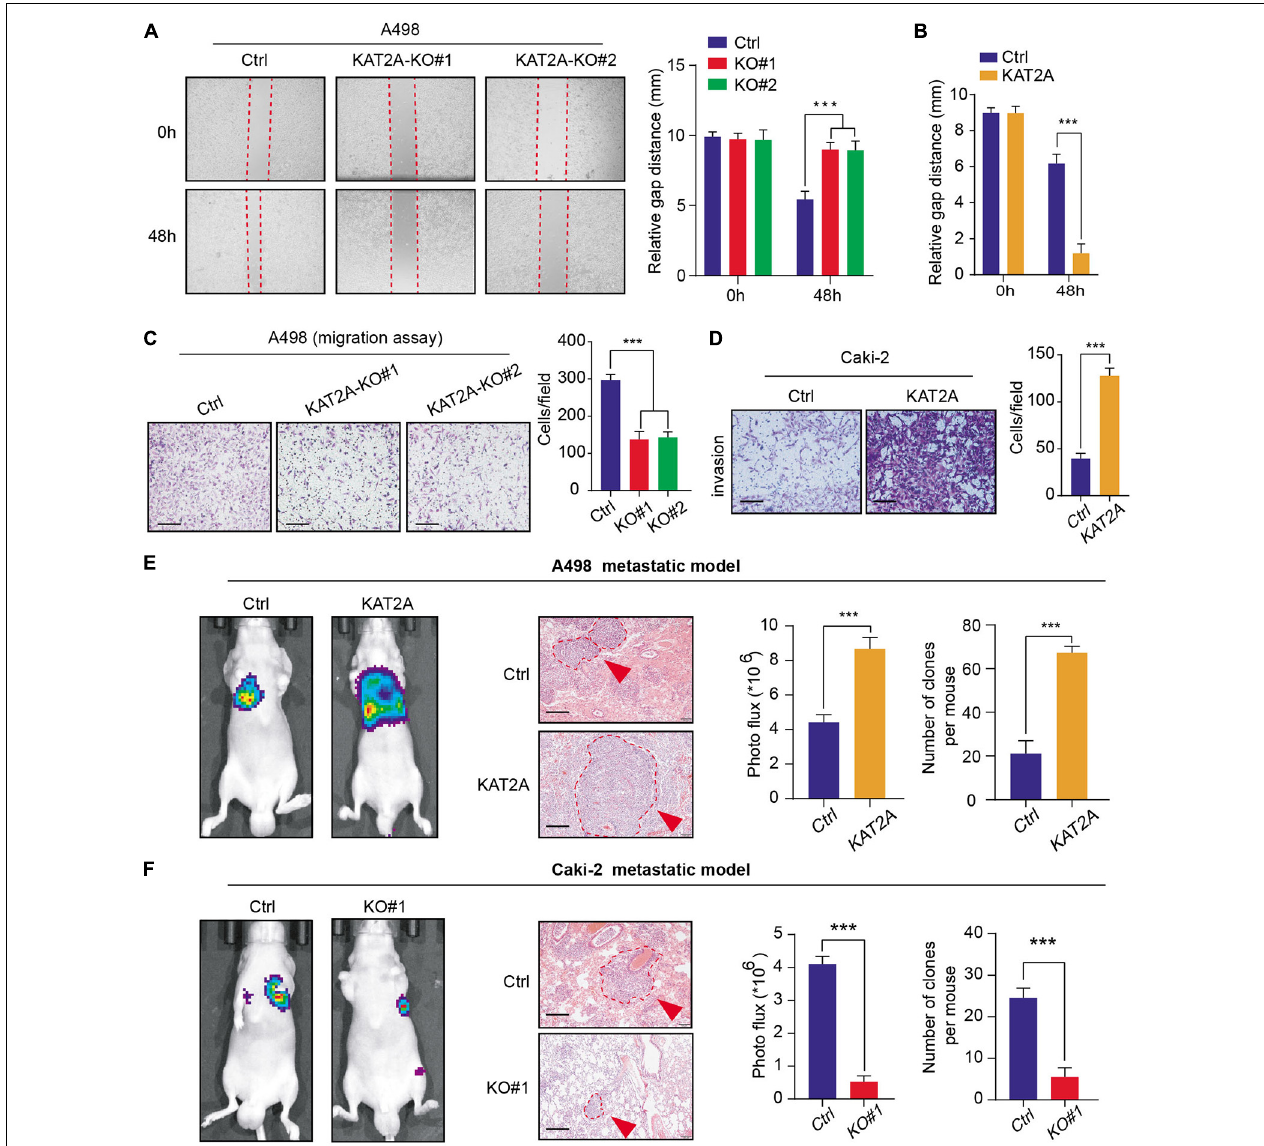
FIGURE 3 | KAT2A enhances RCC metastatic ability in vitro and in vivo . (A) Wound healing assay revealed that KAT2A deficiency significantly inhibit the migration of A498 cells, (B) whereas KAT2A overexpression enhance the migrated ability of A498 cells compared with the control cells. (C,D) Cell migration and invasion experiments of A498 and Caki-2 cells following the knockout or overexpression of KAT2A. Representative pictures were selected (scale bars = 250 µ m) and quantification of the cell migration and invasion assay results were shown on the right of each panel. (E) KAT2A overexpression remarkably enhanced the RCC lung metastasis in nude mice ( n = 5). The representative pictures of bioluminescence imaging (BLI) of mice 8 weeks after portal vein injection of A498 cells with KAT2A overexpression or vector control cells (left). H&E-stained lung sections (scale bars = 250 µ m) (middle). Quantification of the results of BLI signals and lung metastases (right). (F) Additionally, KAT2A deficiency significantly suppressed the distal metastasis of Caki-2 cells. The representative images of bioluminescence imaging (BLI) of mice 8 weeks after portal vein injection of Caki-2 cells with KAT2A ablation or vector control cells (left). H&E-stained lung sections (scale bars = 250 µ m) (middle). Quantification of the results of BLI signals and lung metastases (right). *** P < 0.001.